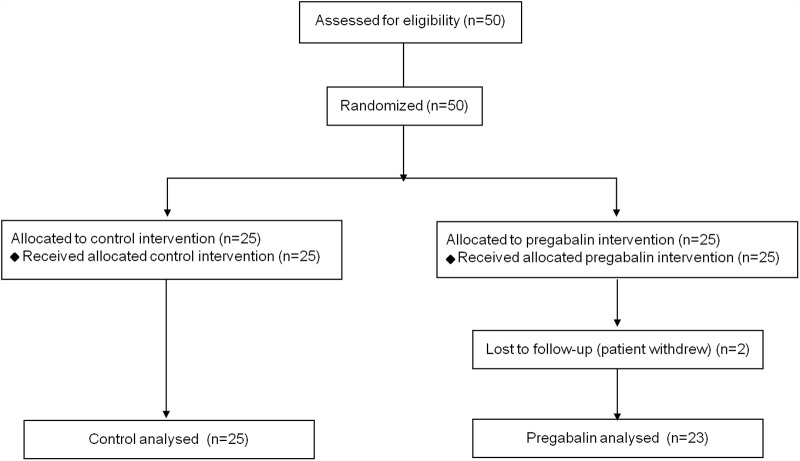
Participant flow diagram.